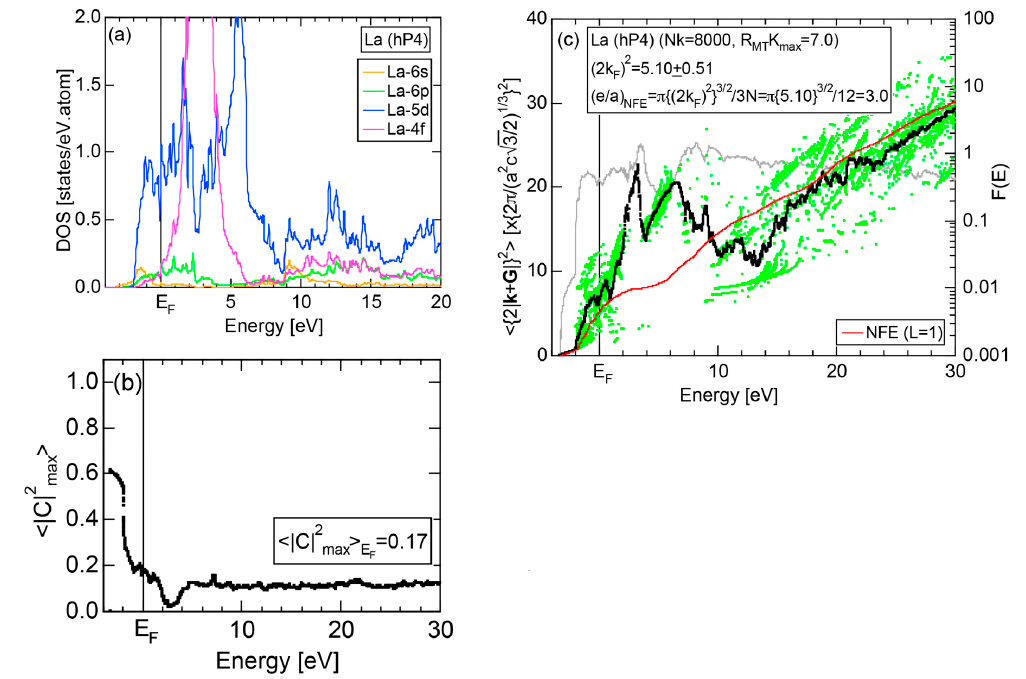
(cid:68) (cid:69) | C | 2 and ( c ) Hume-Rothery plot for La (hP4) max2 max and ( c ) Hume-Rothery plot for La (hP4). See captions E E